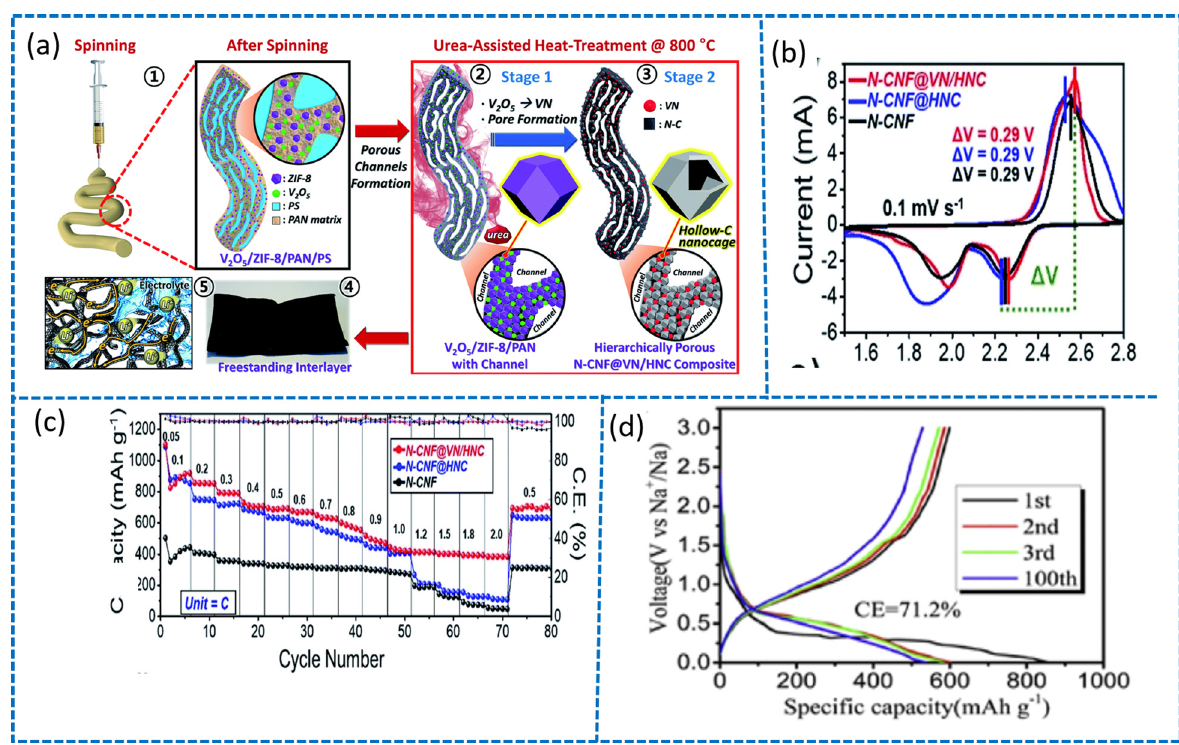
Figure 11: ( a ) Schematic illustration for the construction mechanism of N - CNF@VN/HNC. ( b ) Charge – discharge voltage pro fi les of ( N - CNF@VN/HNC ) at 0.05 C. ( c ) Rate capability analysis of ( N - CNF@VN/HNC ) at di ff erent C - rates [ 104 ] . ( d ) Galvanostatic charge/discharge pro fi le ( current density of 100 mA g − 1 ) [ 222 ]